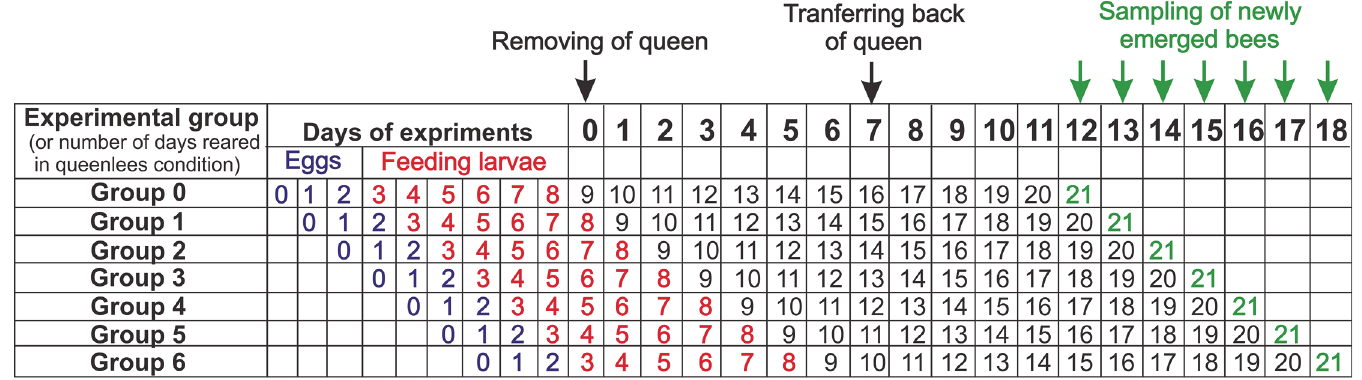
Fig 1. Time schedule of manipulations and the experimental days when workers were sampled from the seven groups (indicated in green). The time of egg incubation is indicated in blue; feeding larvae (unsealed larvae) are indicated in red; and sealed larvae or pupae are indicated in